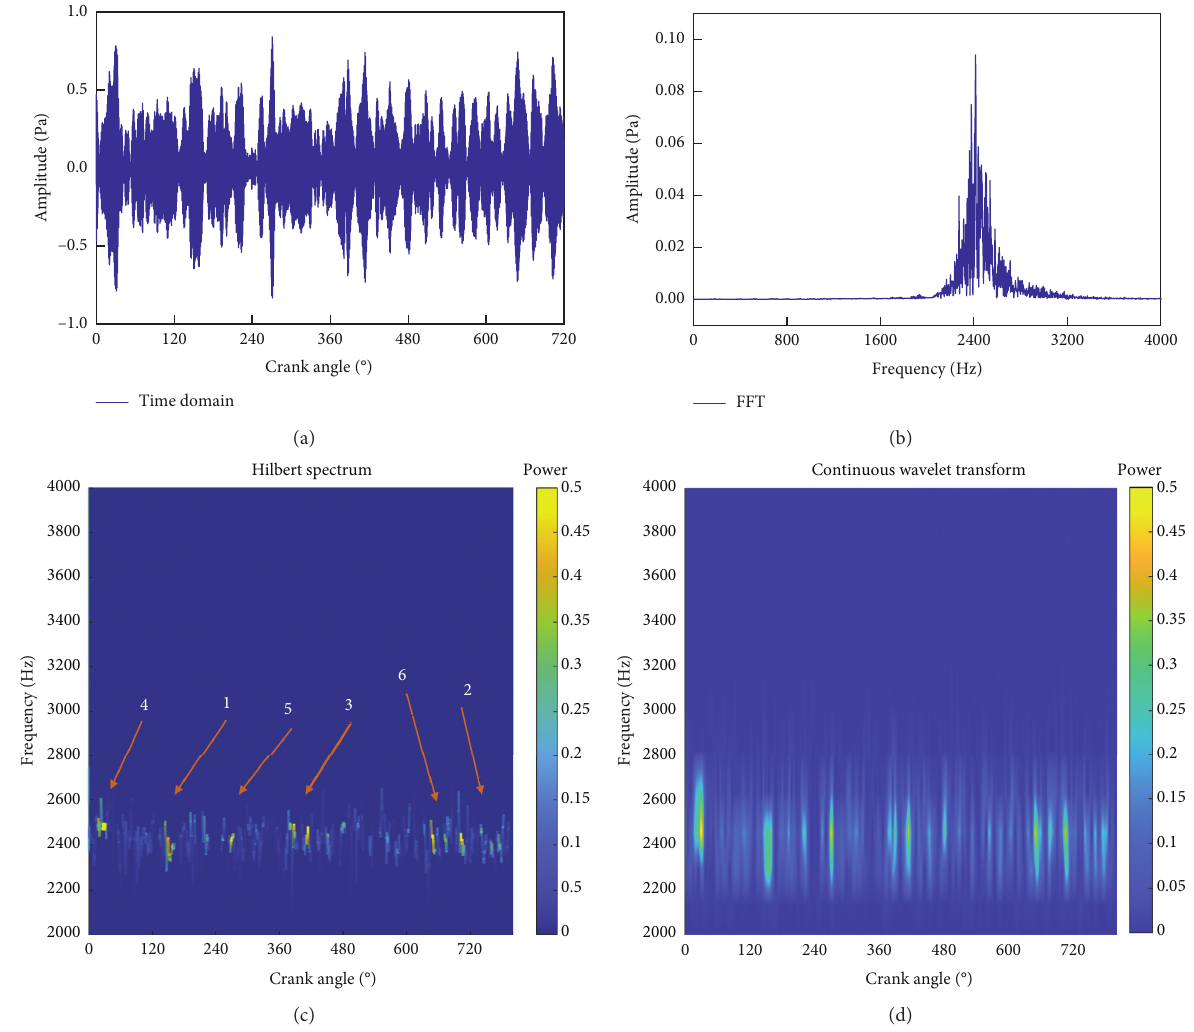
Figure 19: The results of the IC3 component separated by the VMD-FastICA method. (a) Time domain waveform of IC3. (b) Fourier spectrum of IC3. (c) Hilbert spectrum of IC3. (d) Continuous wavelet transform of